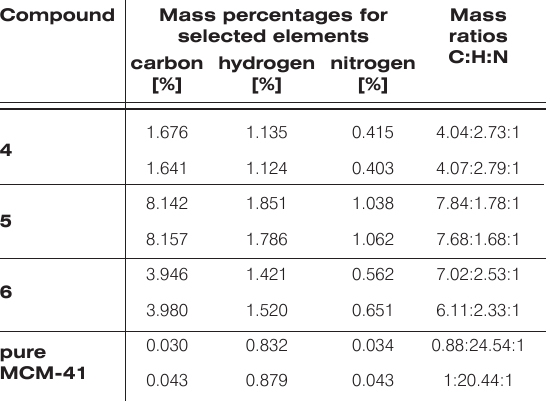
Table 2. Results of elemental analysis for carbon, hydrogen and nitrogen. Compound Mass percentages for selected